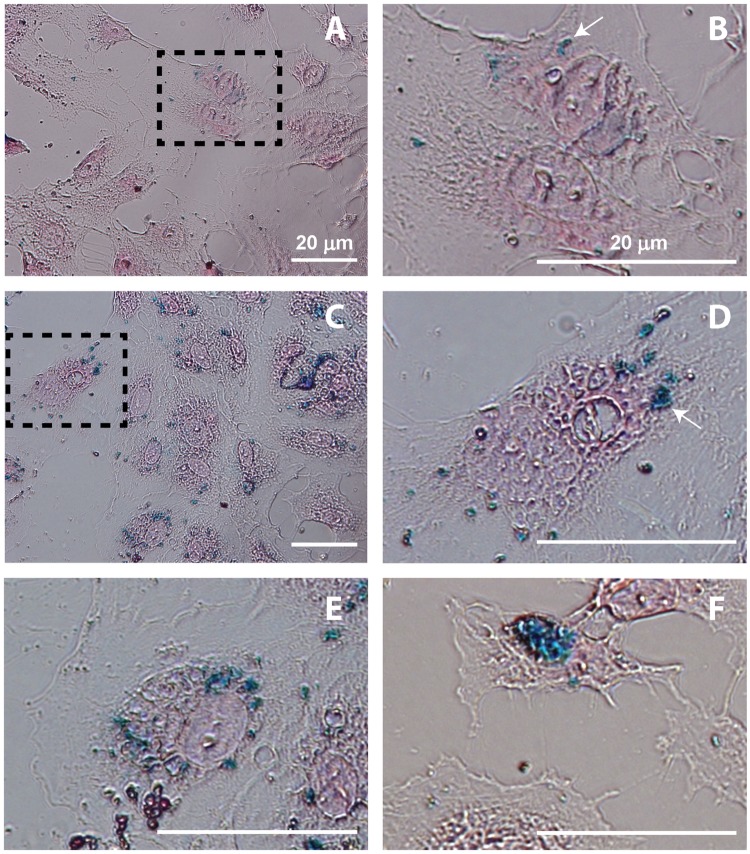
SPIO cell labeling.Prussian Blue staining of SPIO uptake in (A, B) the control (i.e. no ultrasound, 1 h after incubation) and in (C—F) the ultrasound and tMB treated HUVECs at different treatment conditions. C,D,E: 80 kPa PNP, SPIO added at -5 min, 30 s insonification, 1 h incubation after SPIO addition; F: 160 kPa PNP, SPIO added at 15 min, 30 s insonification, 1 h incubation after SPIO addition. B and D are zoomed in from A and C as illustrated by the dashed rectangles. In B and D, one example of a SPIO aggregate is indicated by an arrow.